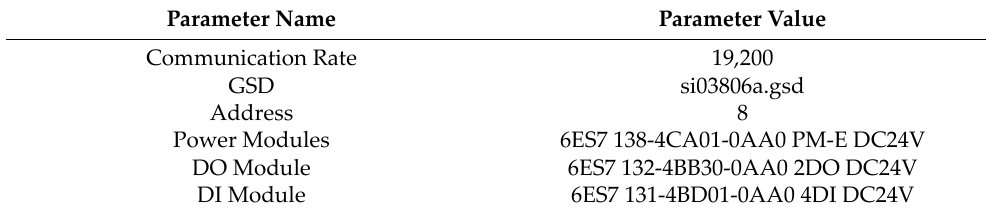
Table 2. Details of ET200 slave configuration parameters.